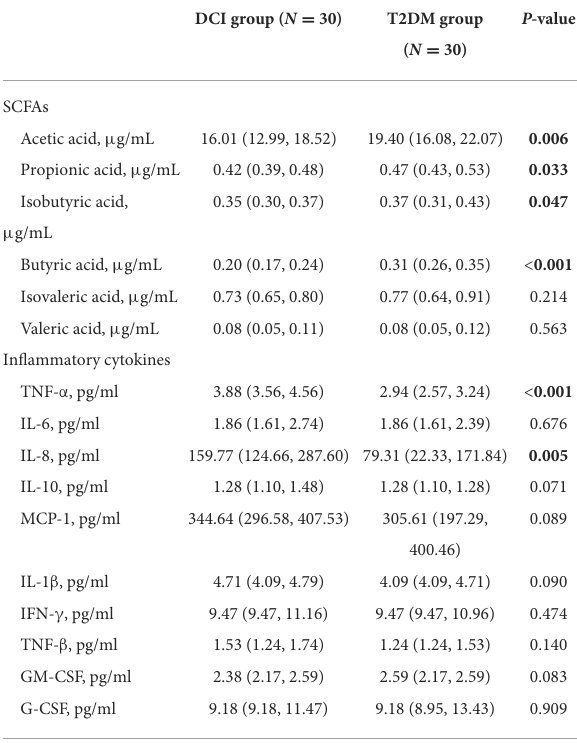
TABLE 3 The plasma concentrations of SCFAs and inflammatory cytokines in DCI and T2DM